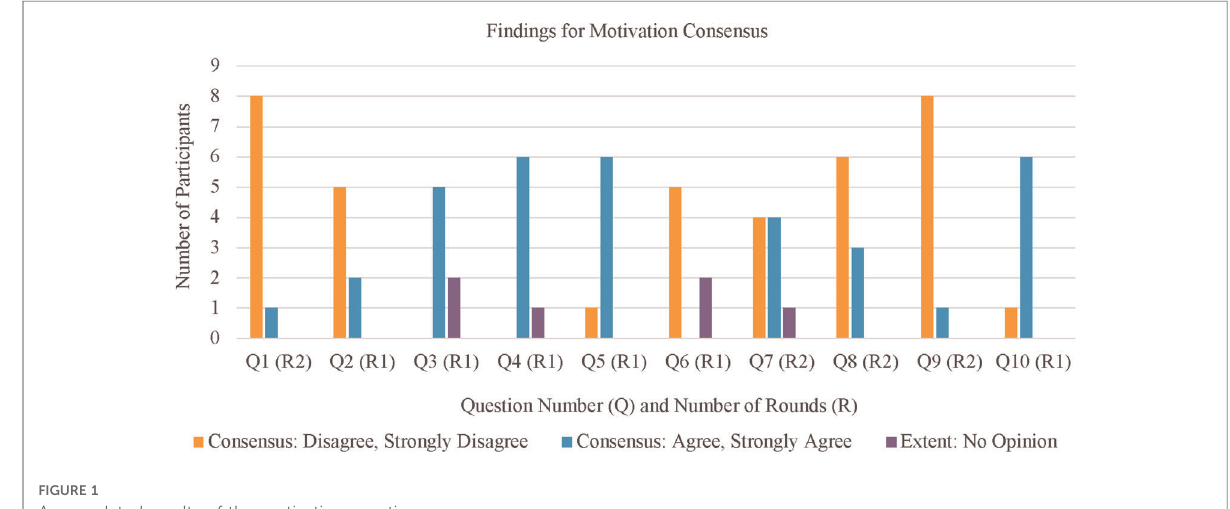
FIGURE 1 Accumulated results of the motivation